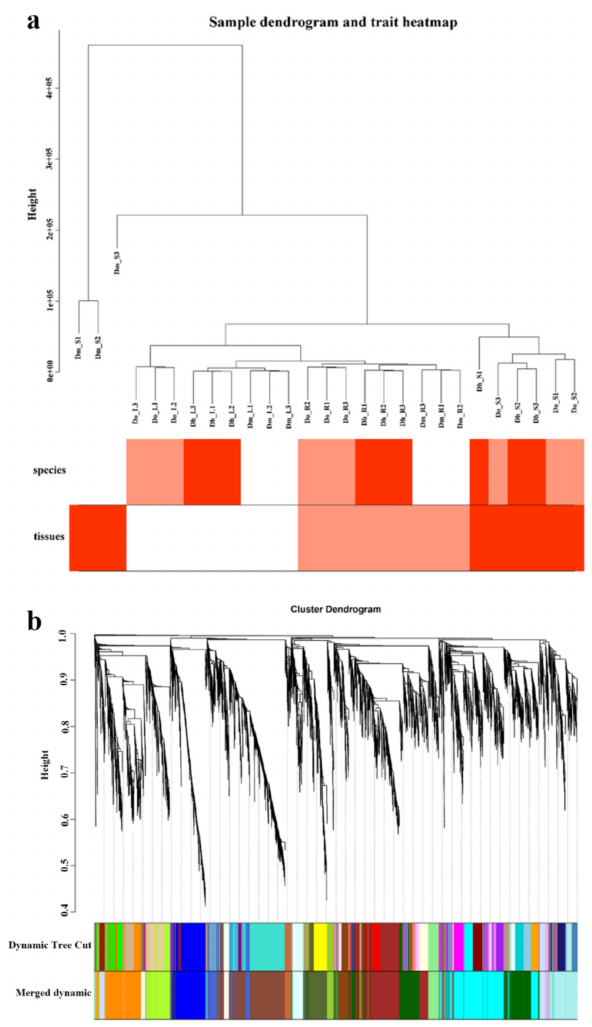
Figure 7. Clustering dendrogram. ( a ) Clustering dendrogram of 27 samples and heatmaps of species and tissues traits. The expression is from low to high, and the color transitions from white to red. ( b ) Clustering dendrogram of DEGs, with dissimilarity based on the topological overlap, together with assigned module colors. The clustered branches represent di ff erent modules, and each line represents one